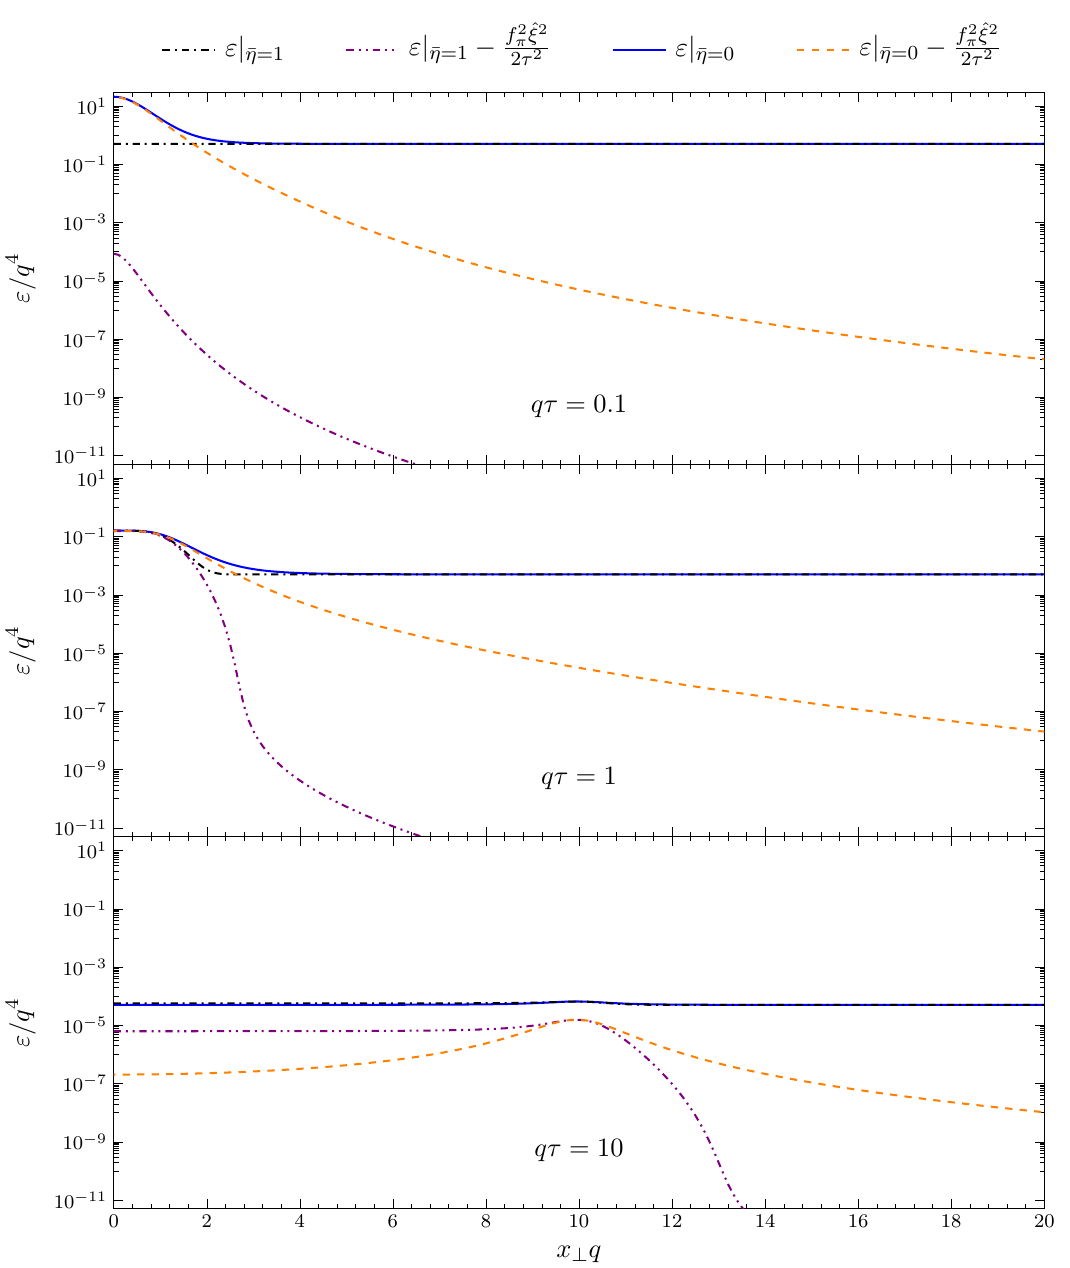
Figure 3. Sample logarithmic plots of the energy density of ideal and viscous superfluid Gubser flow as a function of transverse distance x ⊥ , at different Milne times τ . The solid blue and dashed orange curves show the same data as in figure 2. The dot-dashed black curve shows the numerical result for the energy density at ¯ η = 1 , with τ 0 ≈ 74 /f π and otherwise the same values of parameters as the ideal fluid results. The dot-dot-dashed purple curve shows the ¯ η = 1 result, but with the ˆ ξ 2 / 2 τ 2 subtracted, in order to make the x x ⊥ -independent contribution f 2 ⊥ -dependence π